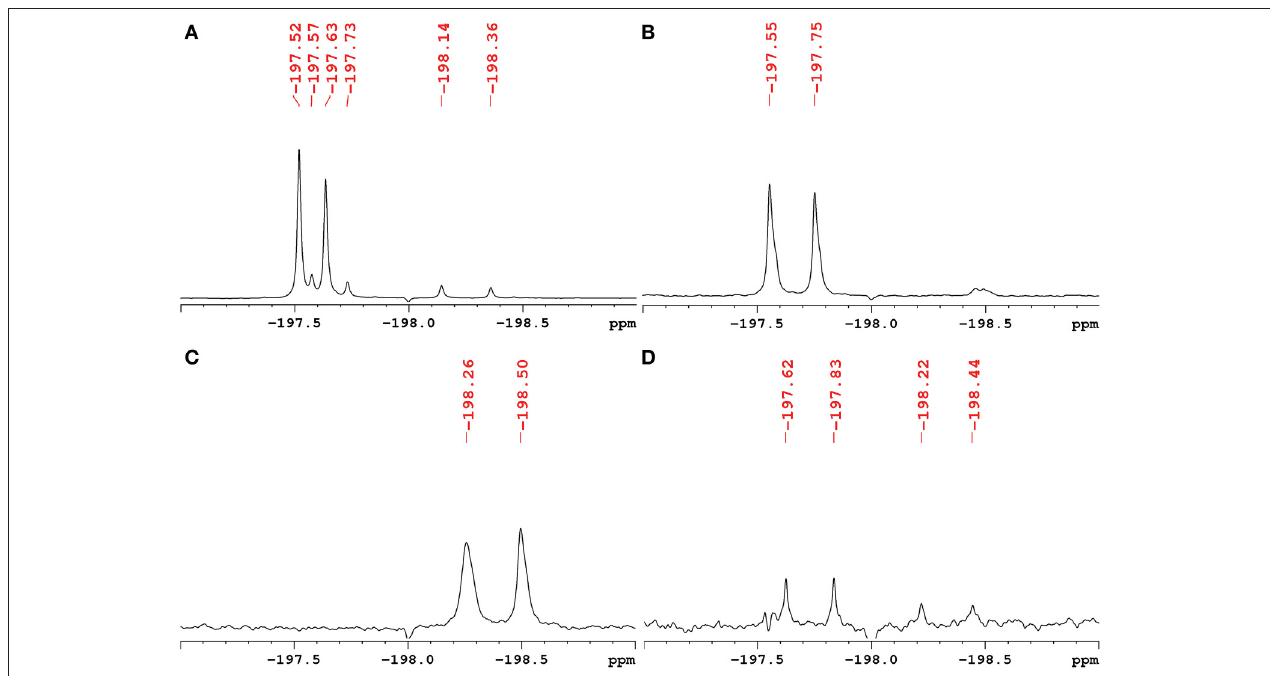
FIGURE 2 | 1 H-decoupled 19 F-NMR spectra of fractions containing fluorinated metabolites including chemical shifts. Signals are referenced to C 6 F 6 at δ F -164.9. (A) Raw extract of A. thaliana after FDG administration before separation. The two most intense signals belong to α -FDG ( δ F − 197 .63) and β -FDG ( δ F − 197 .52). (B) Fraction containing the fluorinated compound α / β -FDG-6-P ( m/z 261.0180). The α -isomer shows a chemical shift of δ F − 197 .75, the β -isomer resonates at δ F − 197 .55. (C) Fraction containing the fluorinated compound α / β -F-maltose ( m/z 343.1051). The compound shows signals that appear most deep-field shifted among the identified metabolites ( α : δ F − 198 .50, β : δ F − 198 .26). (D) Fraction assumed to contain a fluorinated derivative of gluconic acid ( m/z 197.0464).